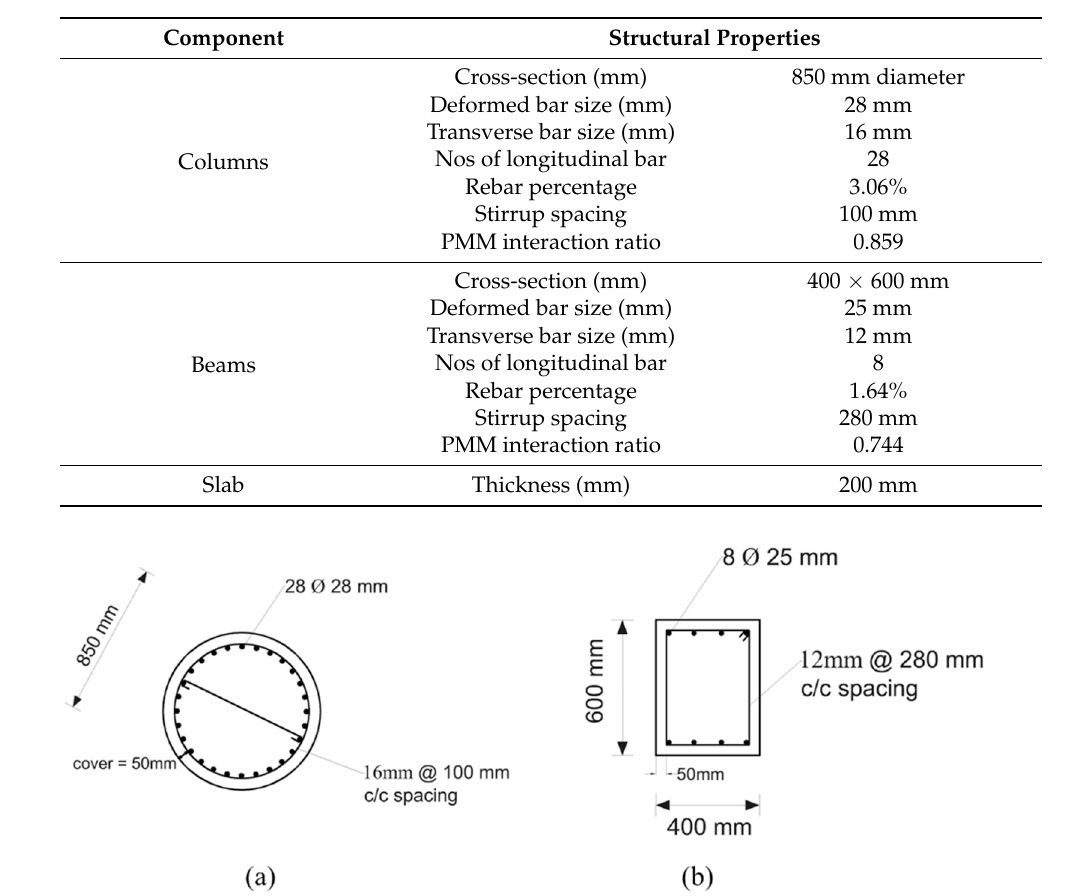
Table 1. Structural properties of the building.